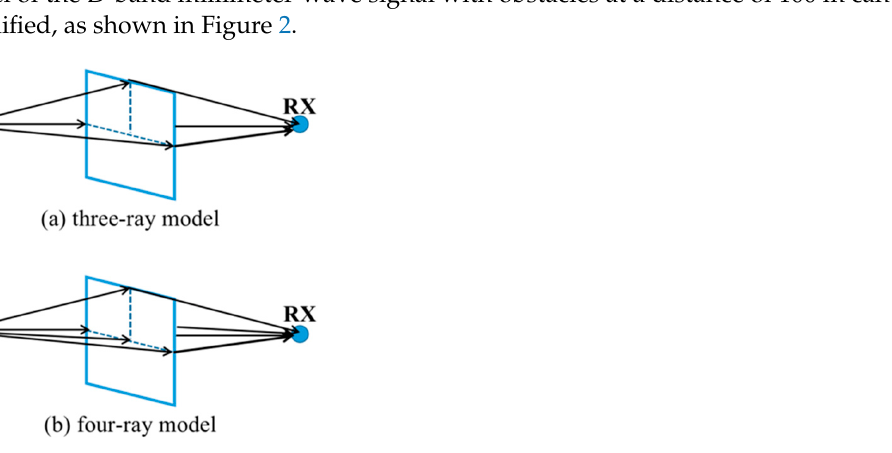
Figure 2. Transmission attenuation model diagrams of D-band millimeter-wave signal passing through obstacles.